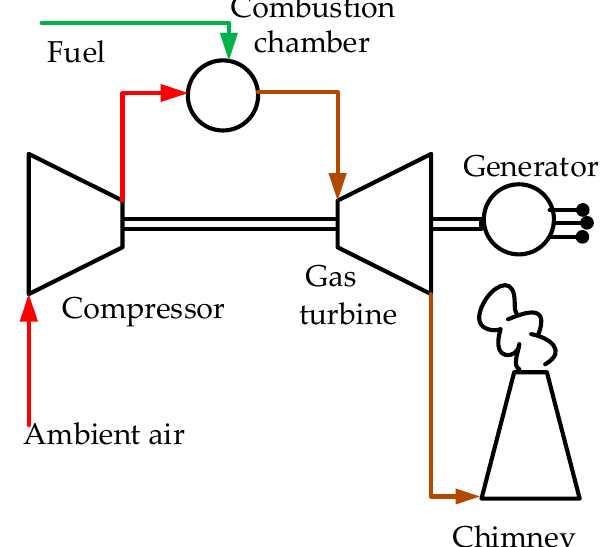
Figure 1. Simple cycle gas turbine unit.